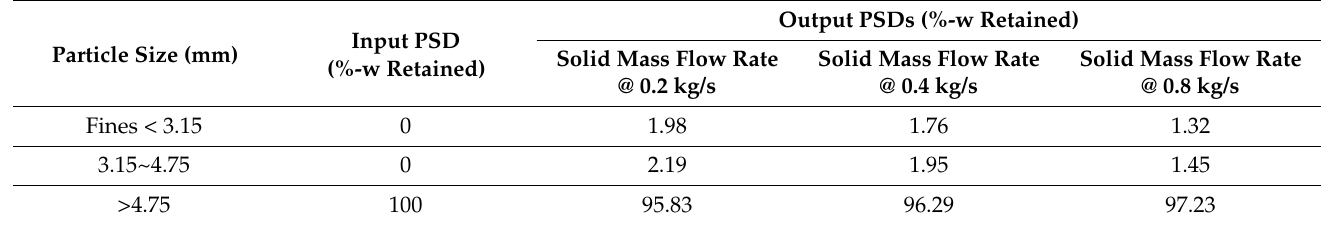
Table 8. Degradation of aged pellets at an air flow rate of 0.24 kg/s with bends in